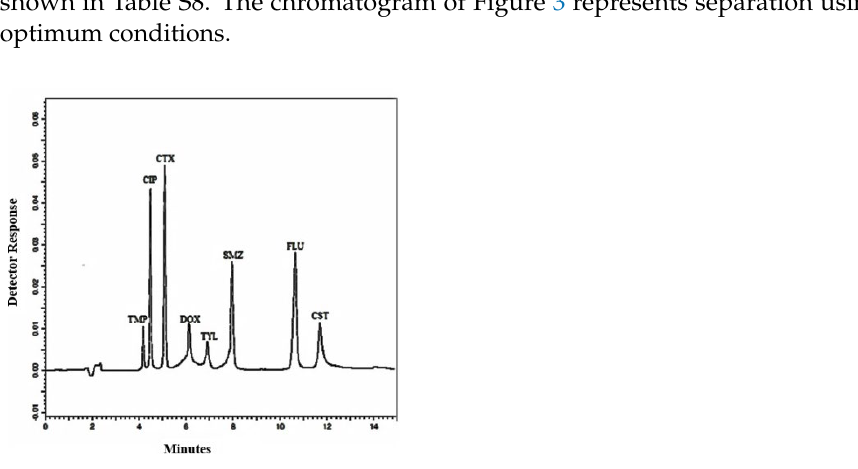
Figure 4. ( a ) Blank chicken sample HPLC-UV chromatogram and ( b ) chromatogram of a blank chicken sample spiked with 300 µg kg −1 of the studied compounds after extraction.